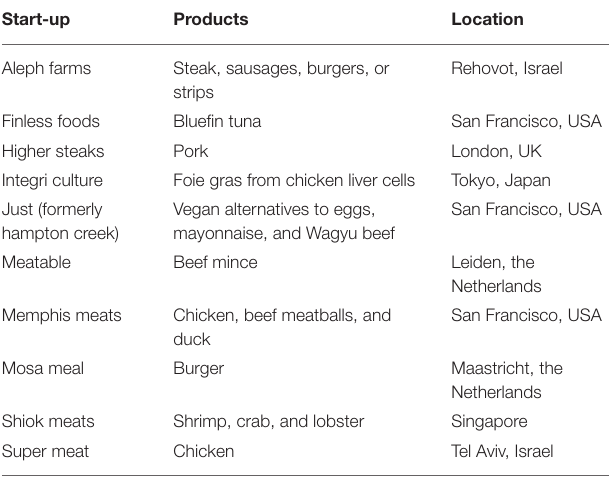
TABLE 3 | Examples of start-ups producing different cultured products around the